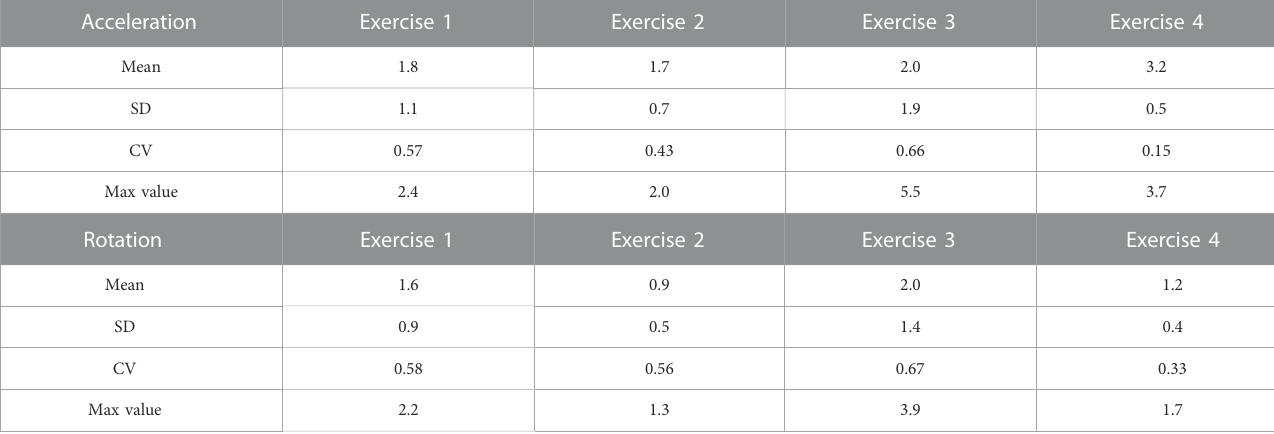
TABLE 2 Acceleration (m/sec 2 ) and rotation (Grad/sec) values during the four exercises in the 14 healthy subjects. Acceleration Exercise 1 Exercise 2